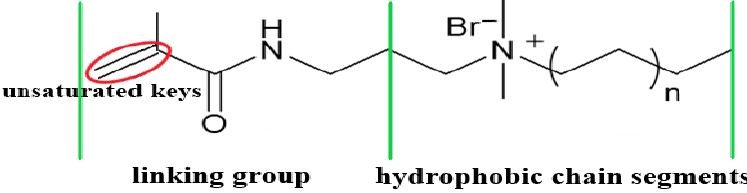
Figure 2. Schematic representation of the CHM structure of the hydrophobic monomer. N -(3-dimethylaminopropyl) methylacrylamide (DMAPMA) (8 g, 0.04 mol), bromo- dodecane (12 g, 0.05 mol), and anhydrous acetone (35 mL) were taken in a three-way flask.